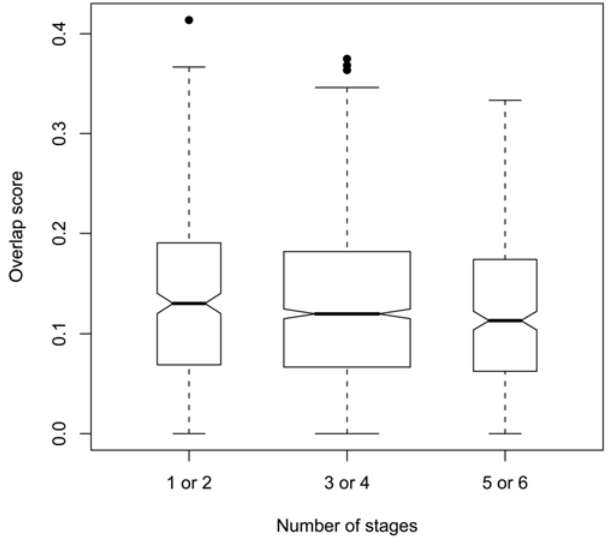
Figure 2. Motif overlap scores of genes present in particular numbers of P.falciparum expression stages. The distribution of P. falciparum - P. vivax motif overlap scores for genes present in 1 or 2, 3 or 4, and 5 or 6 stages suggests that genes present in fewer stages have more conserved upstream regions (more constrained upstream regions) than more broadly-expressed genes. Genes present in 1 or 2 stages have higher overlap scores than those present in 3 or 4 stages (Kolmogorov-Smirnov p-value : 0.036) and those present in 5 or 6 stages (Kolmogorov-Smirnov p-value : 0.013). The width of each box is proportional to the square root of the number of genes each box represents - 1 or 2 stages: 357 genes; 3 or 4 stages: 1411 genes; 5 or 6 stages: 354 genes. The upper edge of each box demarcates the overlap score at the 75 th percentile for genes present in a particular number of stages and the lower edge demarcates the overlap score at the 25 th percentile. The notch in each box occurs at the median overlap score. The lower whisker extends from overlap score at 25 th percentile to 0 and the upper whisker extends from the score at the 75 th percentile to the sum of the score at the 75 th percentile and 1.5 *(score at 75